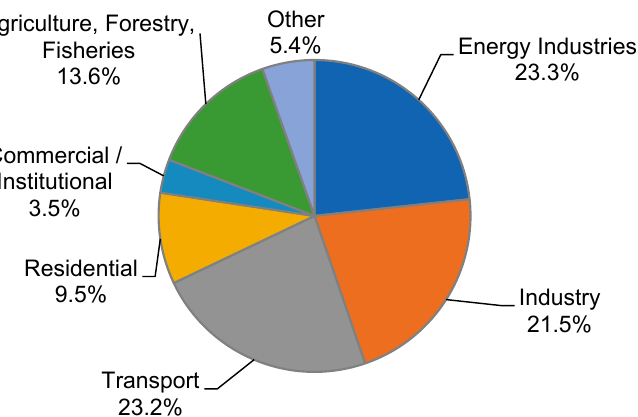
Figure 8. Final consumption of motor gasoline, diesel, biofuels and biogas for transport (shares of total consumption in the country, 2020). Source: Own elaboration based on Eurostat 2022.